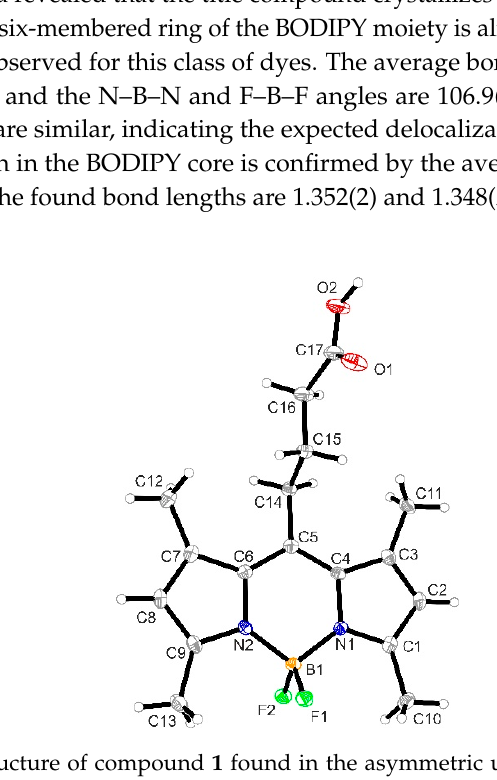
Figure 3. Fourier-transform infrared spectroscopy (FTIR) spectra of 1 in THF and in the solid state showing the O–H ( left ) and C=O ( right ) regions.